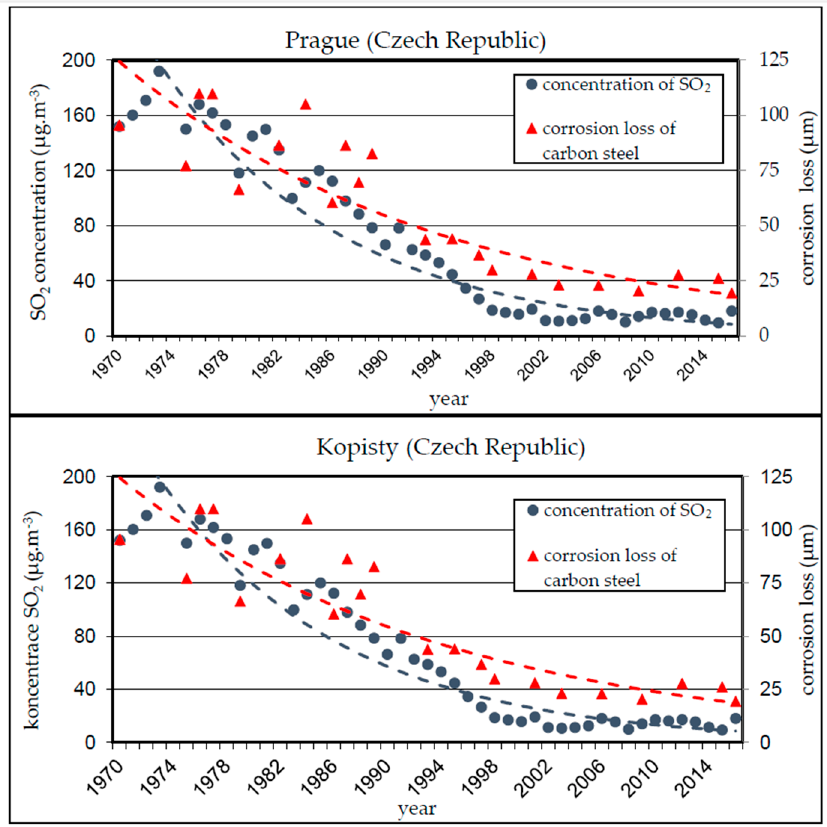
Figure 1. Decreasing concentration of SO 2 and one year corrosion losses of carbon steel (CS) in atmospheric test sites Prague and Kopisty (Czech Republic).